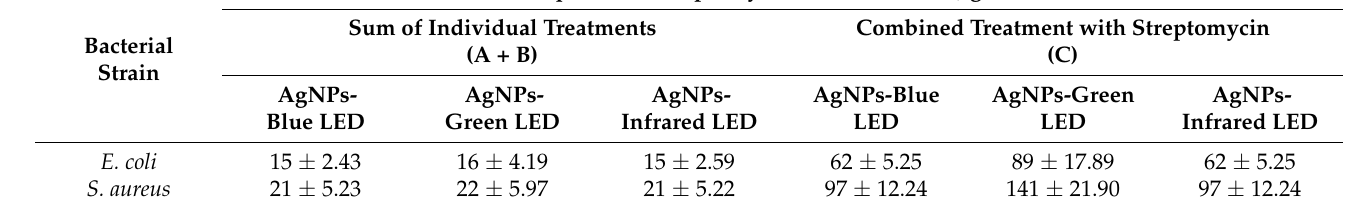
Data are expressed as the means ± SE (n = 3 replicates). Table 6. The evaluation of combined treatment with AgNPs and streptomycin and the sum of individual treatments expressed as equivalent streptomycin concentration calculated by the regression equation.